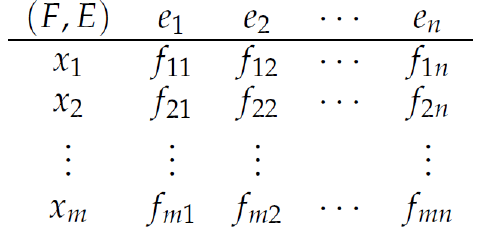
Figure 1. A soft set ( F , E ) presented in its tabular